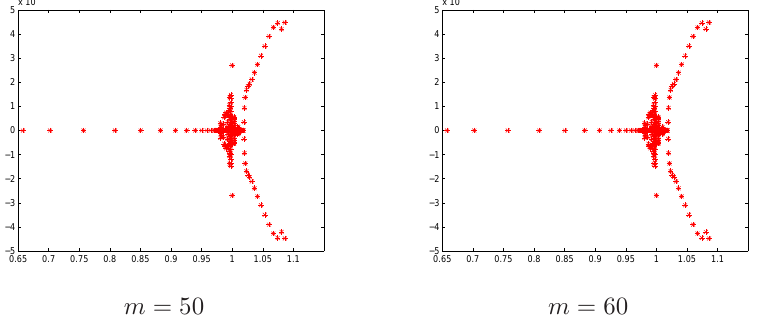
Figure 3. The spectrum of the preconditioned matrix M − 1 A for m = 50 and m = 60